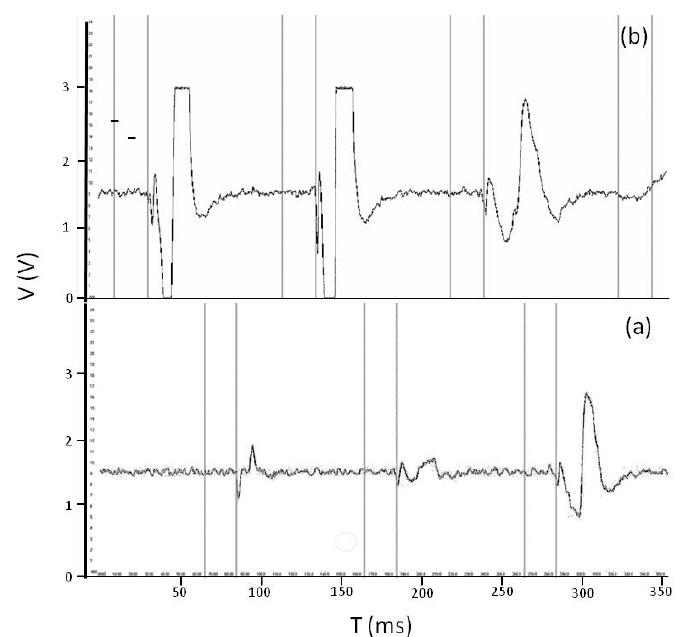
Figure 6. Figures show the electrical signals generated by three smaller Collembola (Folsomia candida) ( a ) and three larger Collembola (Orchesella cincta) ( b ). The first vertical line designates when the animal fell in and detection started. The signal was saved between second and third vertical lines. X-axis shows time period in ms and Y-axis shows voltage in mV.